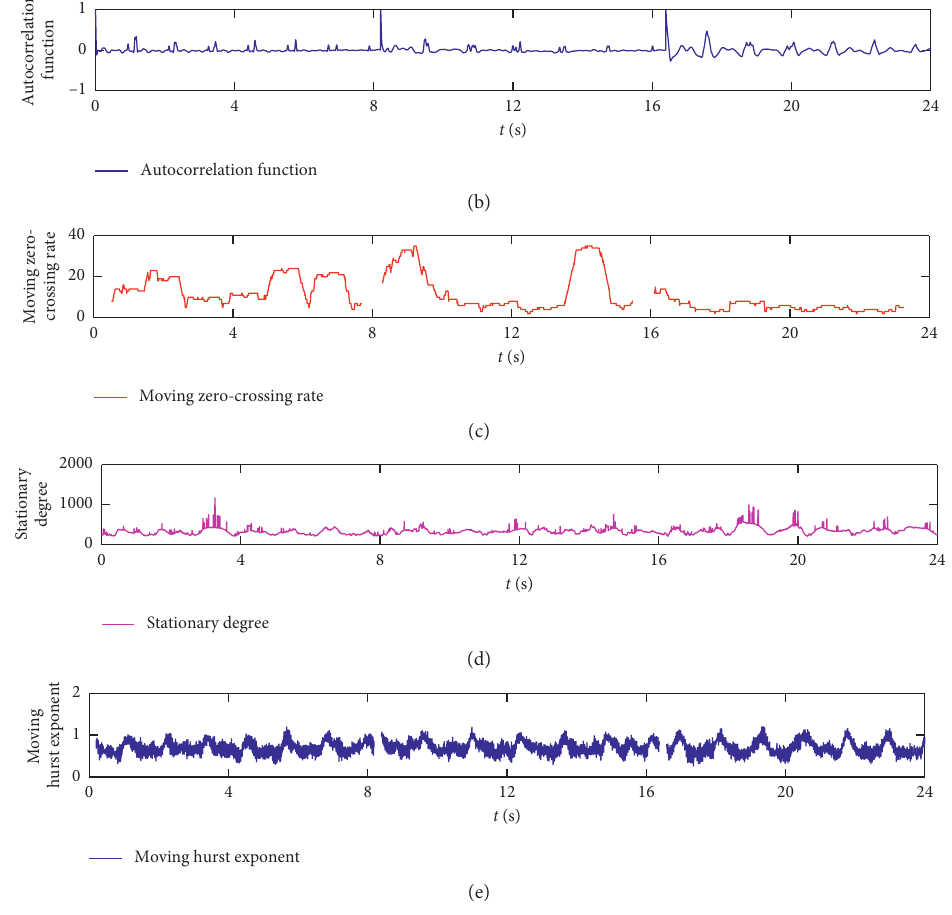
Figure 6: Analysis of ECG signal based on typical algorithms.